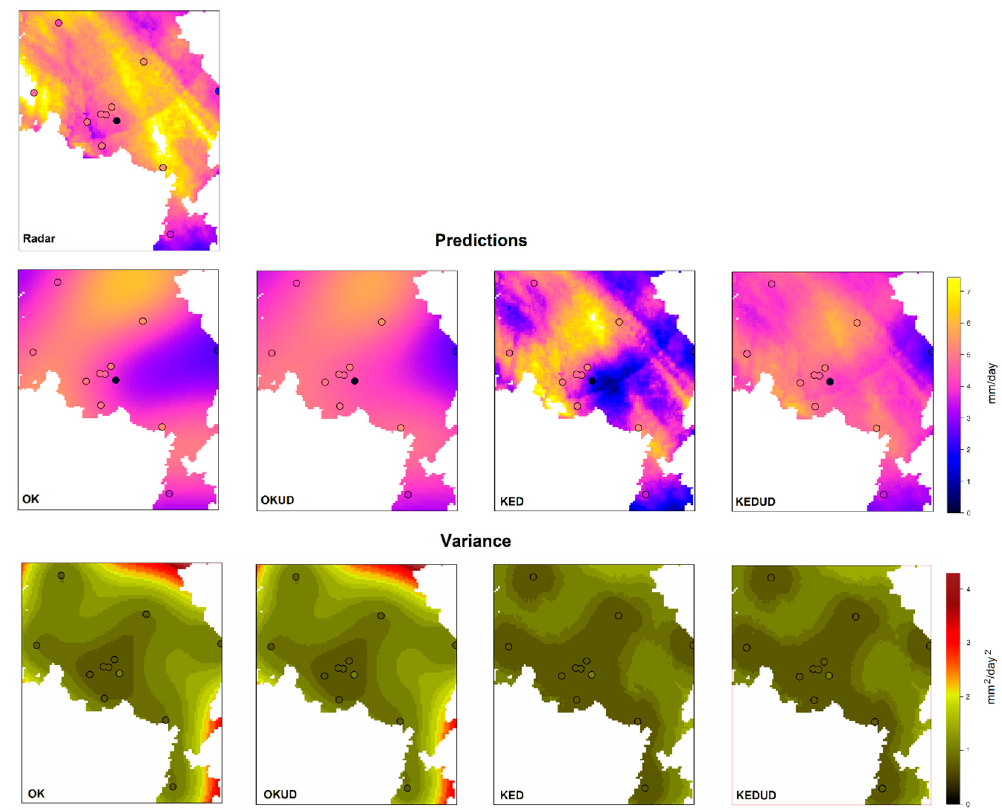
Figure 5. Kriging prediction and kriging variance for each of the four rainfall products. Rain gauge rainfall intensities and rain gauge estimated nuggets are superimposed to the kriging predictions and to the kriging variance, respectively, using the same colour scales. The top-left panel shows the radar rainfall estimation used for KED and KEDUD.